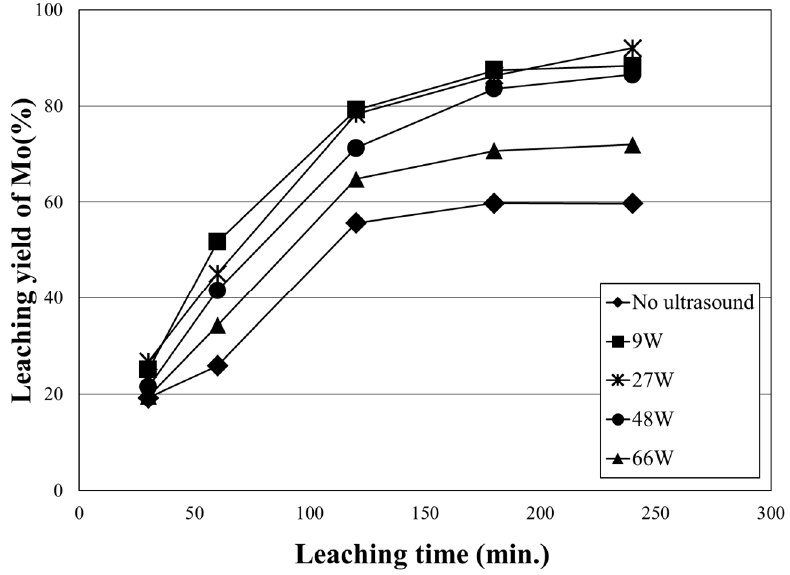
Figure 8. Leaching yields of molybdenum with time at various sonication powers (current density: 0.292 A/g, pulp density: 5%, temperature: 25 °C).